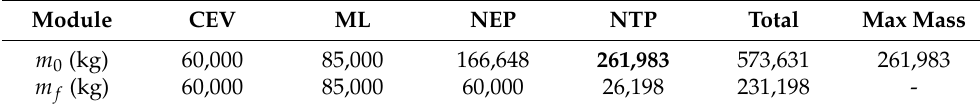
Table 18. Mass scale of